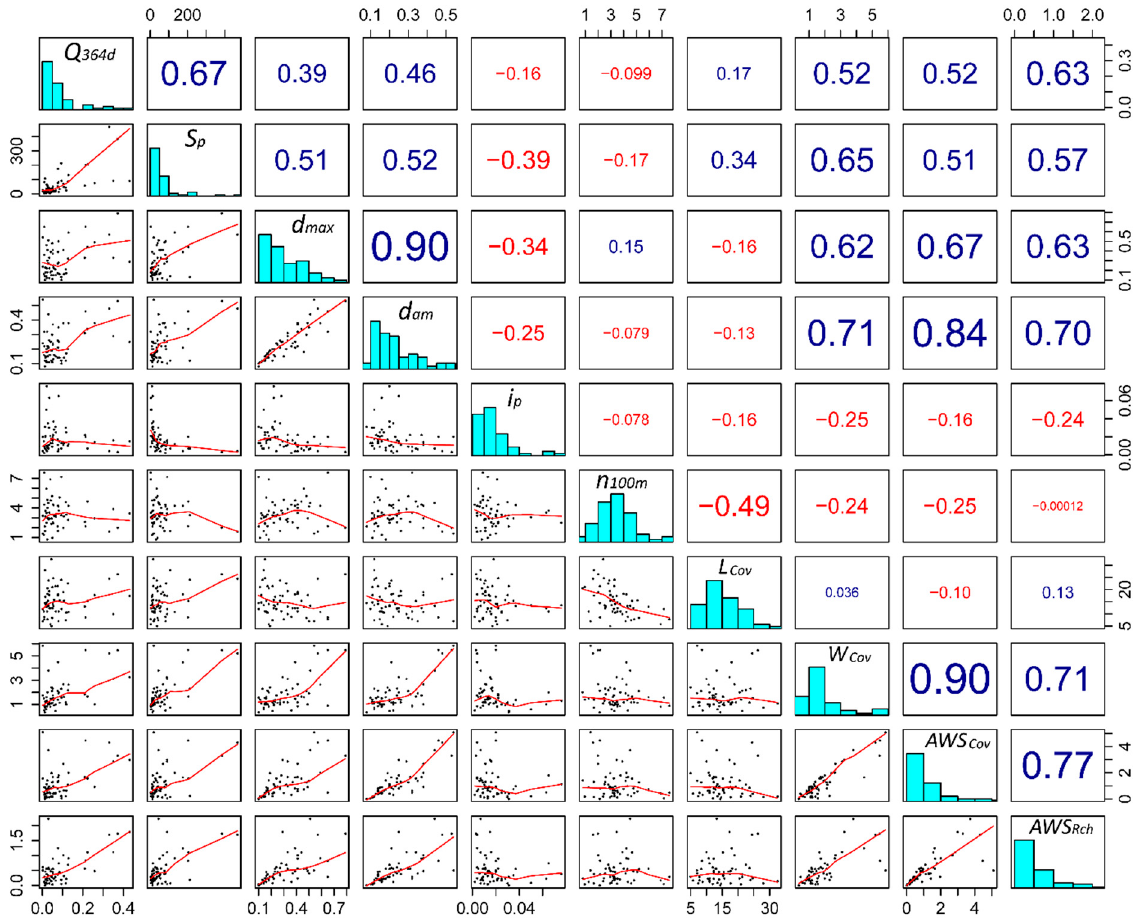
Figure 4. Correlation matrix between microhabitat properties and the value of the area-weighted suitability for the monitored fish covers and reaches ( AWS Cov and AWS Rch , respectively). On the vertical and horizontal axis, there are scales for each individual parameter in accordance with Table 1. Each scale corresponds to a parameter range from Table 1.